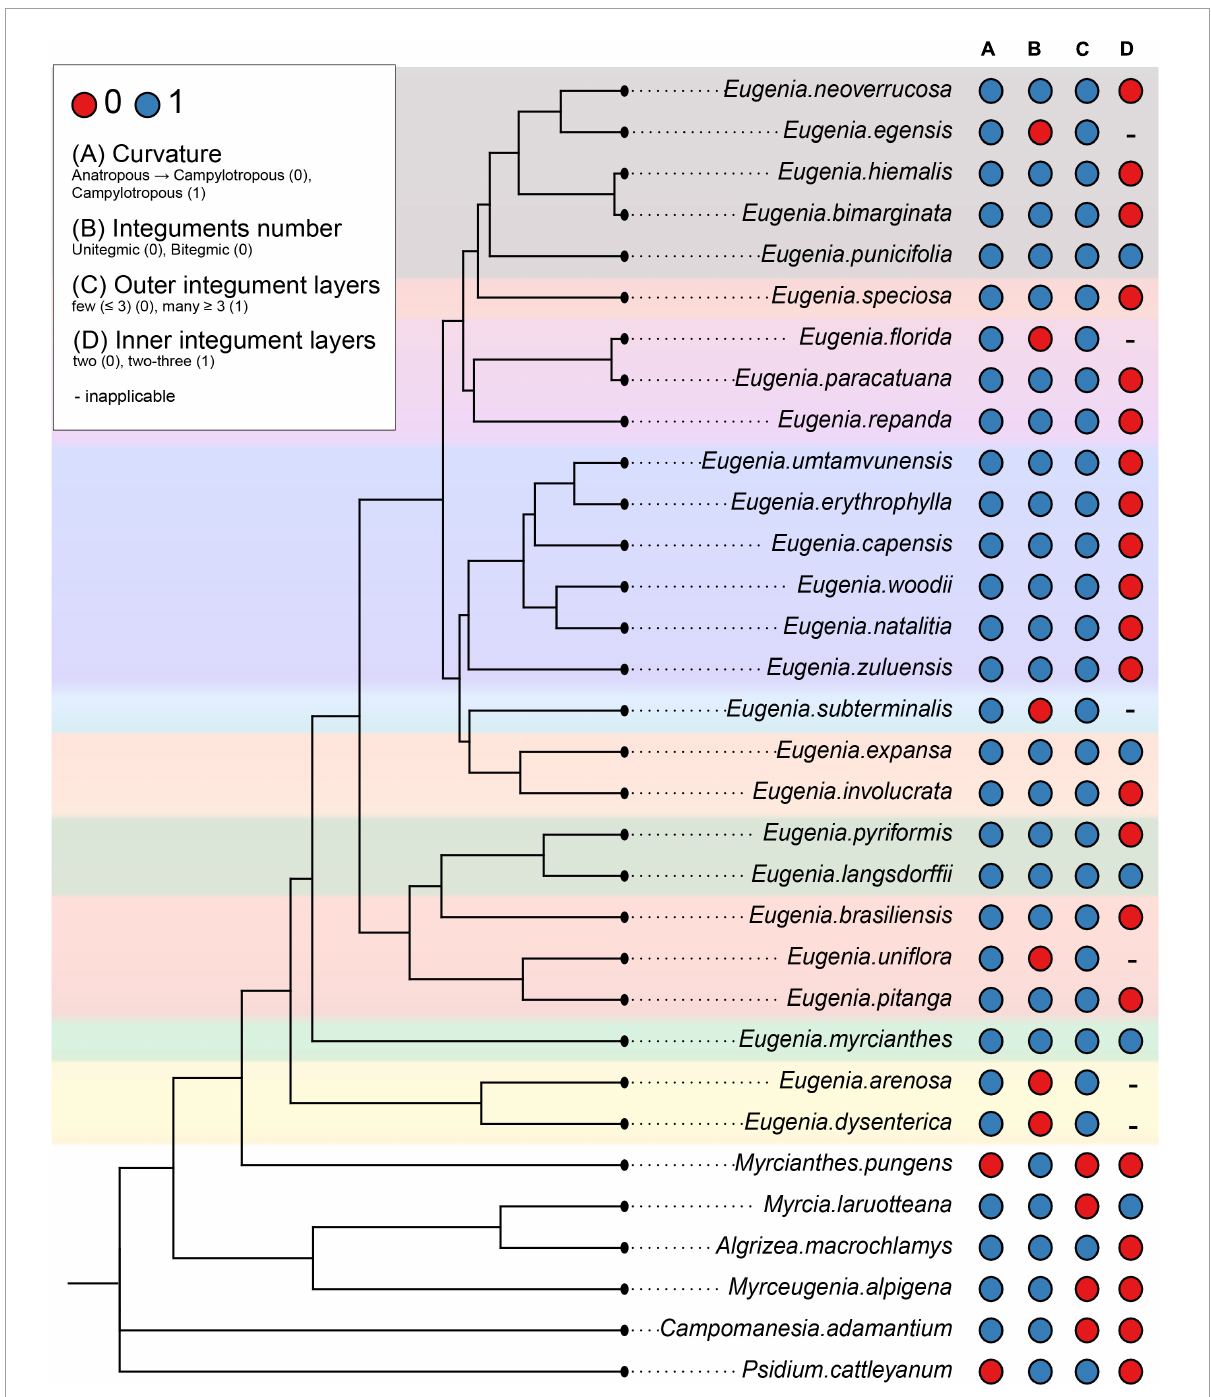
FIGURE6 Eugeniinae phylogeny with species character states of ovule: curvature (A) , integuments number (B) , outer integument layers (C) , and inner integument layers (D) ( Eugenia sect. Pseudeugenia ; E. sect. Hexachlamys ; E. sect. Eugenia ; E. sect. Pilothecium ; E. sect. Phyllocalyx ; E. sect. Schizocalomyrtus ; E. sect. Jossinia ; E. sect. Racemosae ; E. sect. Speciosae ; E. sect. Umbellatae ).